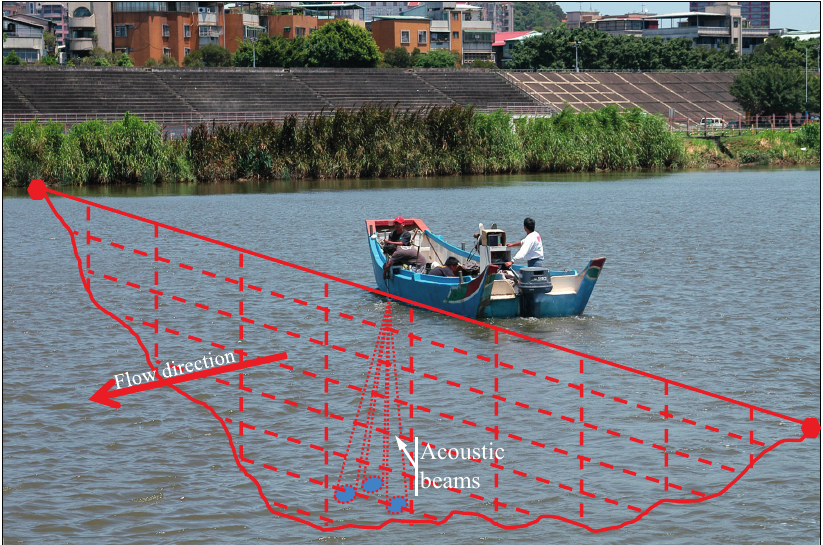
Figure 1. Schematic of the discharge measurement and bathymetric survey field